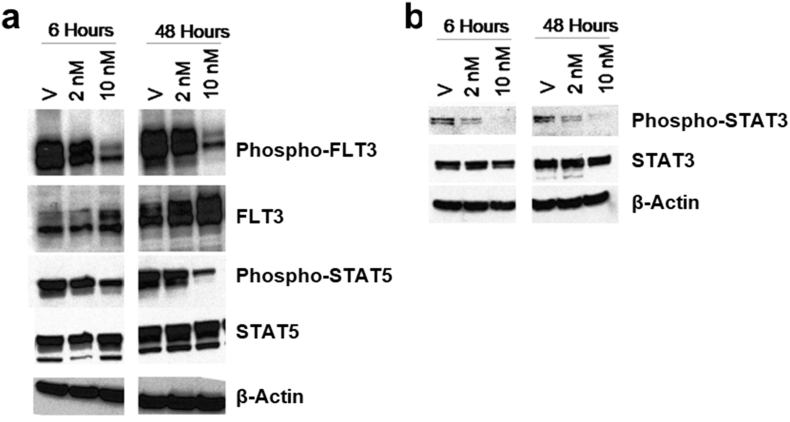
Evaluation of the effect of HSN431 on protein phosphorylation in MV4–11 cells. Cells were treated with 2 nM or 10 nM HSN431 for 6 h and 48 h and protein extracts were probed with primary antibodies of (a) phospho-FLT3, FLT3 phospho-STAT5 and STAT5 and (b) phospho-STAT3 and STAT3. Primary antibodies of indicated kinases or proteins were detected using anti-rabbit or anti-mouse secondary antibodies. Scanned images were analyzed using image J software. For full immunoblots, see Fig. S6.